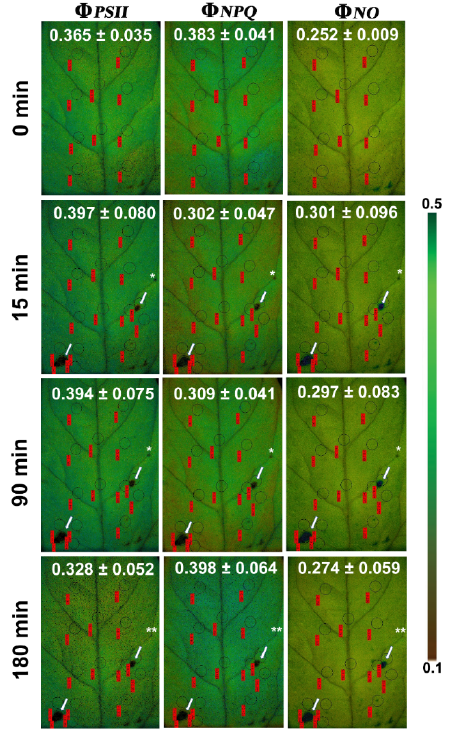
Figure 5. Representative color-coded images of effective quantum yield of PSII photochemistry ( Φ PSII ), regulated non-photochemical energy loss ( Φ NPQ ), and non-regulated energy loss ( Φ NO ) of a tomato leaflet before insect feeding (0 min; upper row), immediately after (15 min; second row), and post-feeding period (90 and 180 min; lower two rows). Ten initial measurement areas (areas of interest: AOIs) are shown in circles with their associated measurements in red labels; the corresponding values for the whole leaflet (average ± SD) are given in white. At 15 min, two AOI (shown by white arrows) were added to cover each spot of herbivory (feeding spot) and three more adjacent to and as close as possible to the two feeding spots (surrounding area). The single asterisks at 15 and 90 min mark an additional minor feeding spot, which recovered later (indicated by two asterisks at 180 min). The color code on the right side of the images shows pixel values ranging from 0.1 (dark green) to 0.5 (dark